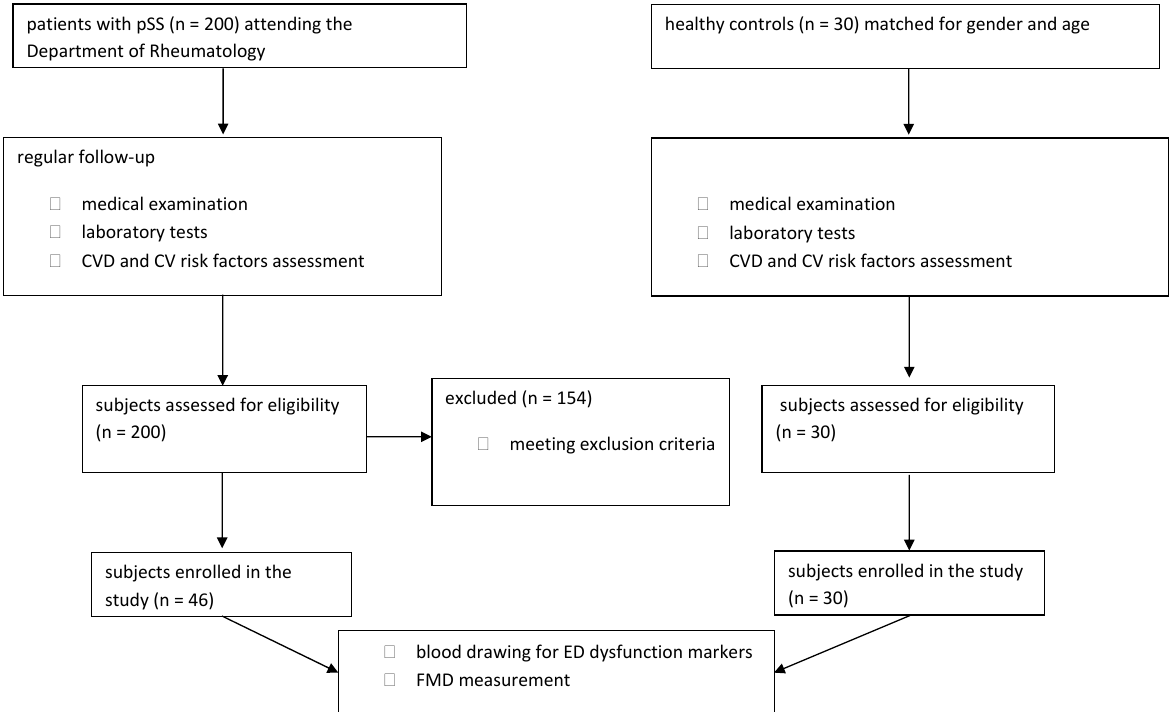
Figure 1. A flow chart presenting the subjects’ recruitment and analyses performed in this study. Abbreviations: CV—cardiovascular; CVD—cardiovascular disease; ED—endothelial dysfunction; FMD—flow mediated dilation; pSS—primary Sjogren syndrome.